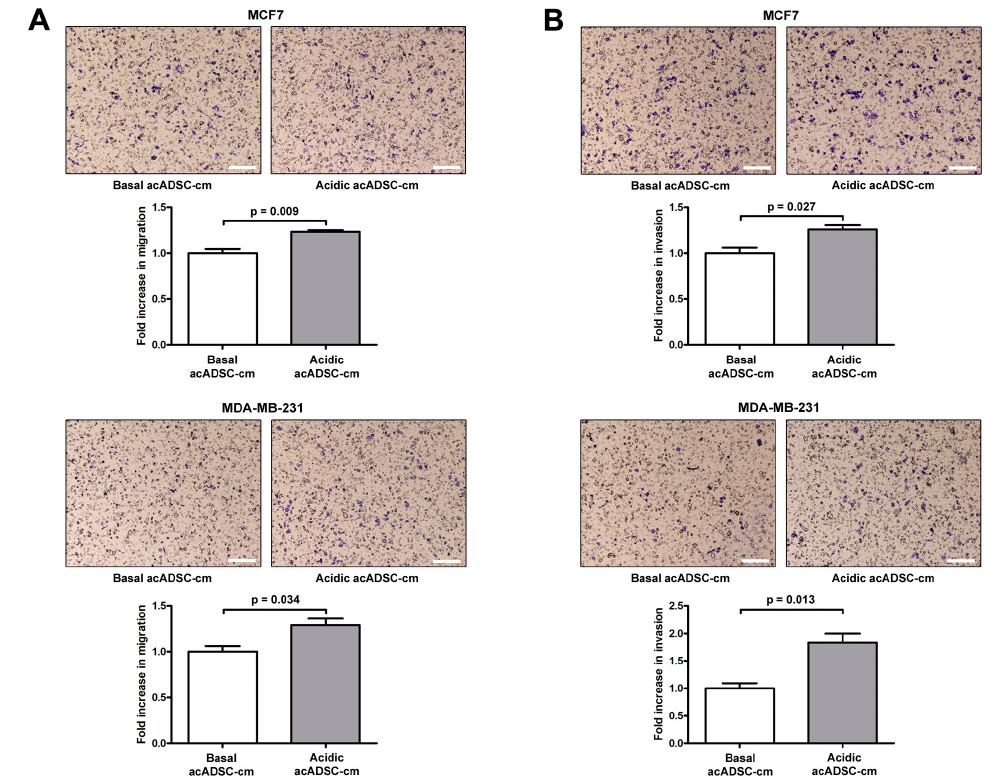
Figure 9. Representative images and relative quantification charts of migration ( A ) and invasion ( B ) assays on MCF7 (top panel) and MDA-MB-231 (bottom panel) cells treated for 24 h with conditioned media produced by adipocyte-committed adipose-derived stem cells (acADSCs) grown either under basal (pH 7.4) conditions (basal acADSC-cm) or under lactic acidosis (acidic acADSC-cm). Images of filters stained with Diff-Quik dye are shown. Scale bar: 250 µ m. Migration/invasion of cells treated with basal acADSC-cm was set to 1, and the other results are normalized to this value. Bars represent the mean ± SEM of three independent experiments ( n = 3 replicates each). Values of p were determined by unpaired Student’s t -test.